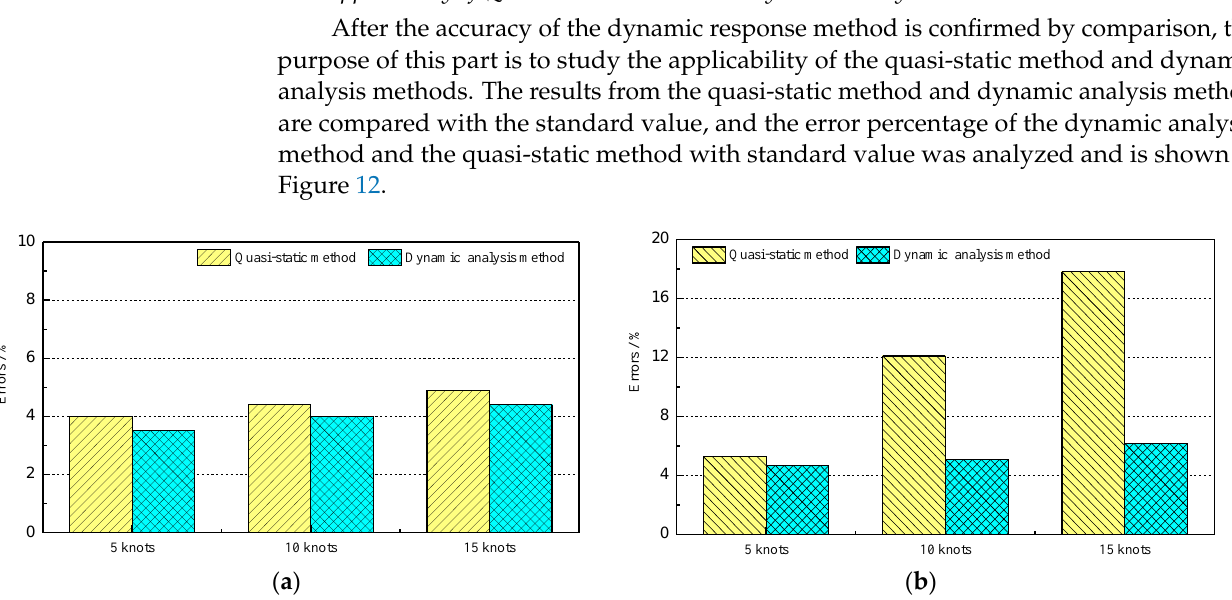
Figure 12. Errors of the stress. ( a ) Without slamming effect; ( b ) With slamming effect.